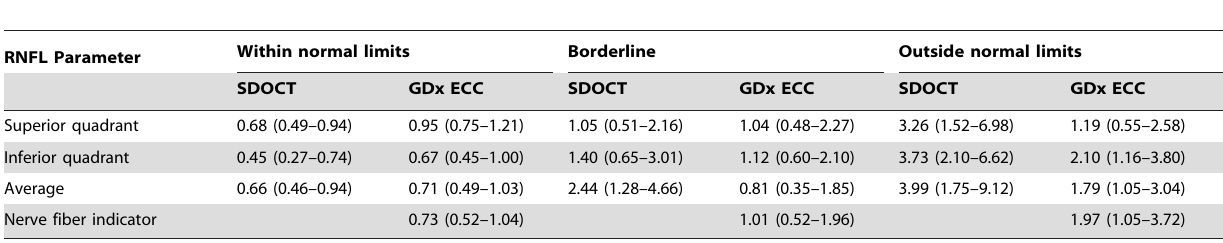
Table 4. Likelihood ratios (with 95% confidence interval)* of the normative database classification of SDOCT and GDx ECC parameters to discriminate glaucoma from control